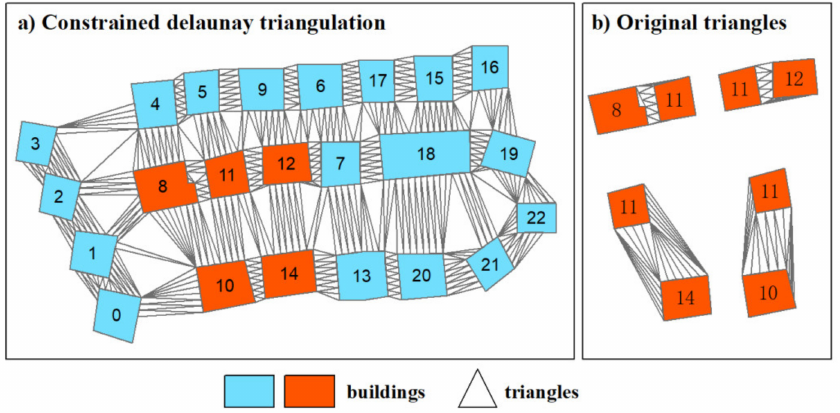
Figure 1. Examples for constrained Delaunay triangulation are shown for ( a ) triangulation constructed for all buildings within each individual block and ( b ) triangulation constructed for each pair of adjacent